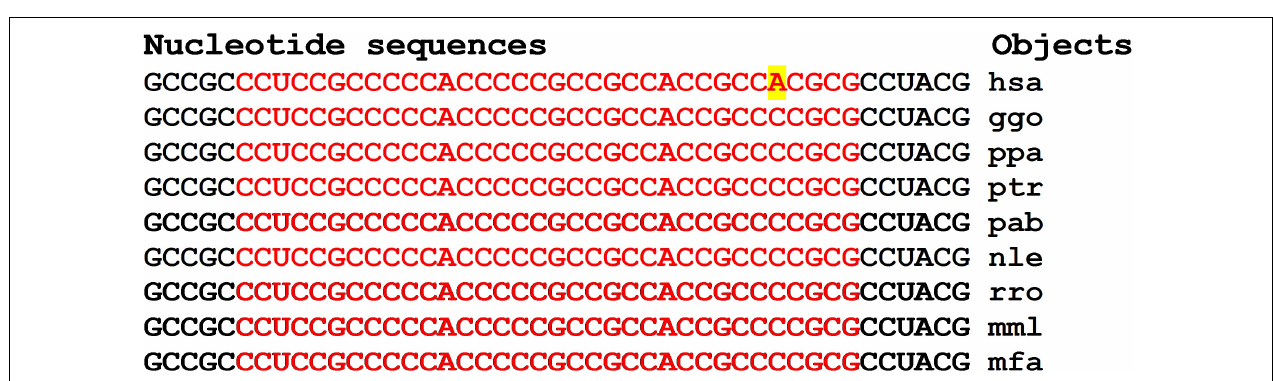
FIGURE 9 | Nucleotide sequences of CDS regions of mRNAs of orthologous FOXO1 genes containing clusters of miRNAs binding sites.